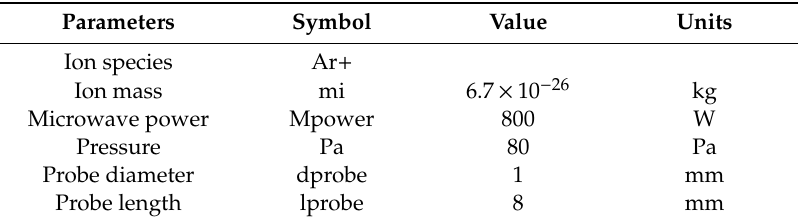
Table 1. Parameters of the coaxial microwave driven plasma and Langmuir probes used to measure electron temperature and density.